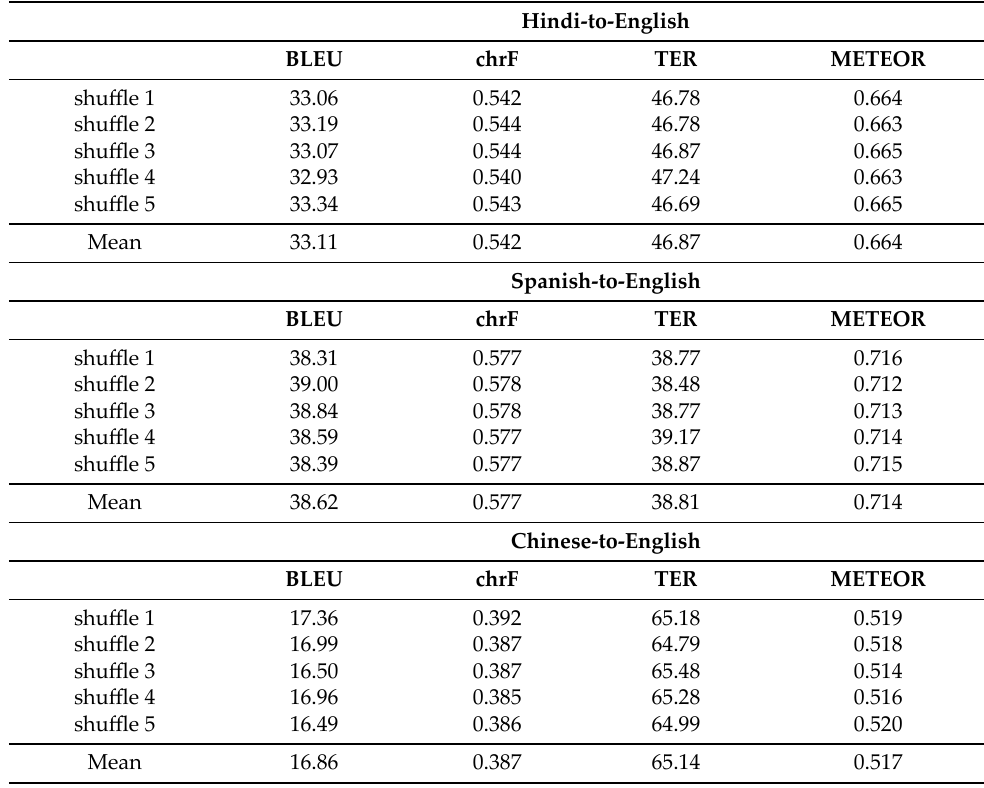
Table 5. Performance of NMT systems (HAN) on shuffled